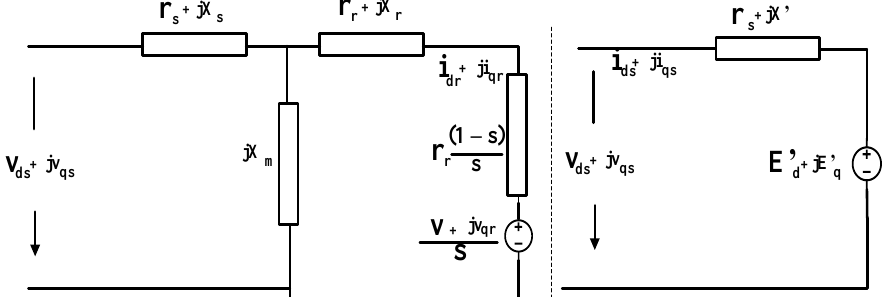
Figure 2. DFIG equivalent circuit for steady-state and dynamic responses.